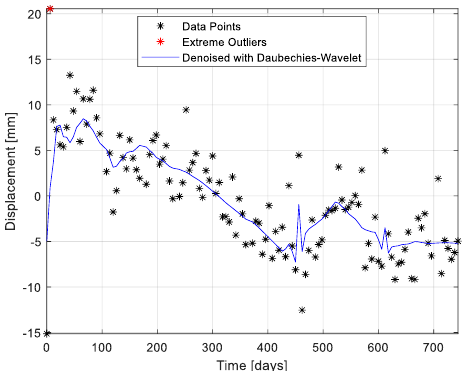
Figure 8. Original displacement time series of PS 3 (black stars), extreme outliers (red), and the de-noised signal